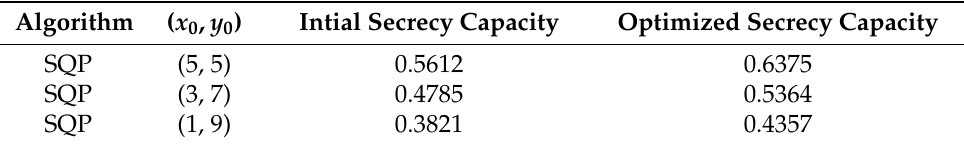
Table 10. Influence of the Initial Point on Secrecy Capacity (SQP).